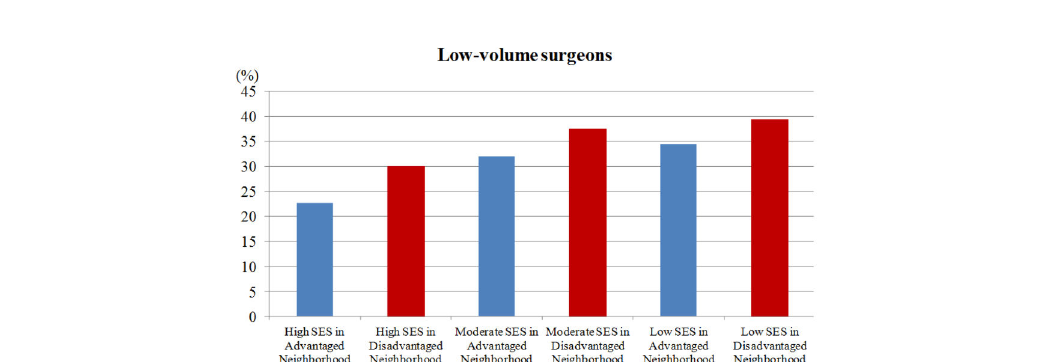
Figure 2. The proportion of receiving breast cancer surgery from a low-volume surgeon in breast cancer patients by individual and neighborhood